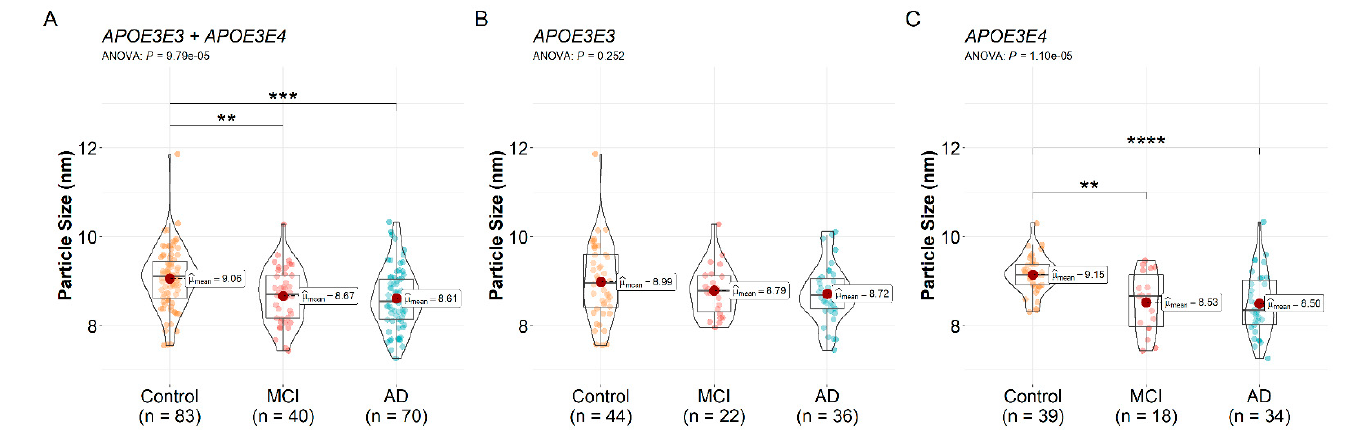
Figure 3. High-density lipoproteins particle size is reduced in MCI and AD patients. Mean particle diameter (nm) between ( A ) the controls, mild cognitive impairment (MCI), and Alzheimer’s disease dementia (AD) patients and controls, MCI, and AD patients stratified by the ( B ) APOE3E3 and ( C ) APOE3E4 genotypes. One-way ANOVA followed by Tukey’s multiple comparison tests was used. ** p < 0.01, *** p < 0.001, and **** p < 0.0001.